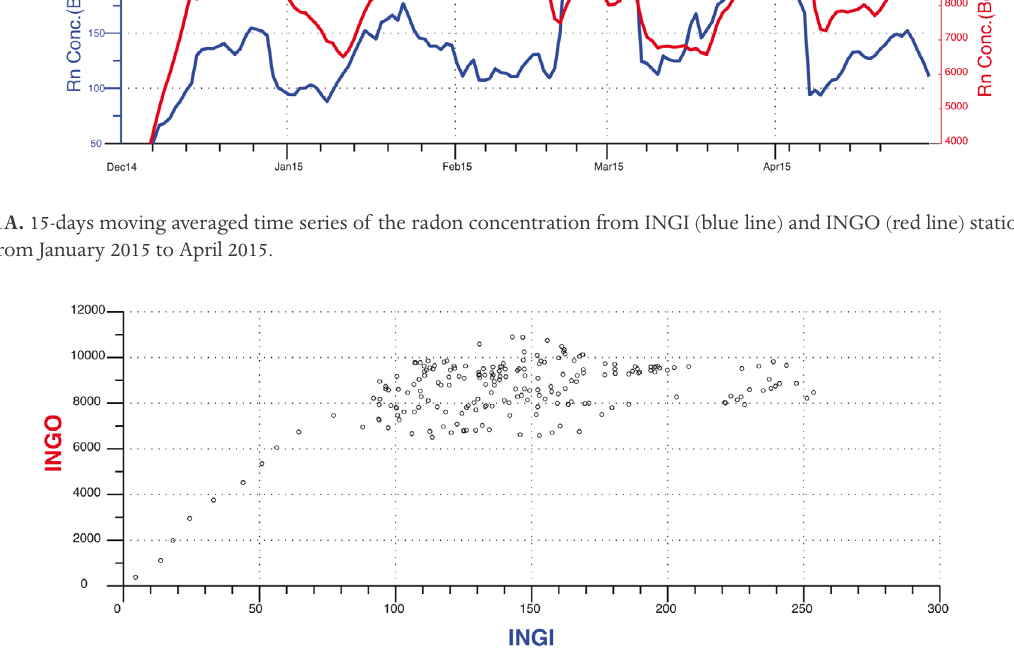
Figure 2A. INGO radon concentration versus INGI radon concentration during the period from January 2015 to April